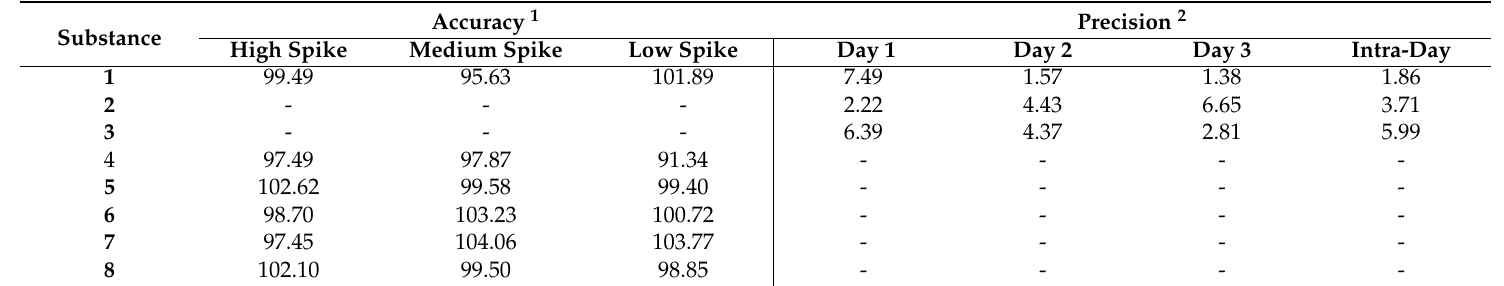
Table 3. Accuracy and precision of the new coumarin